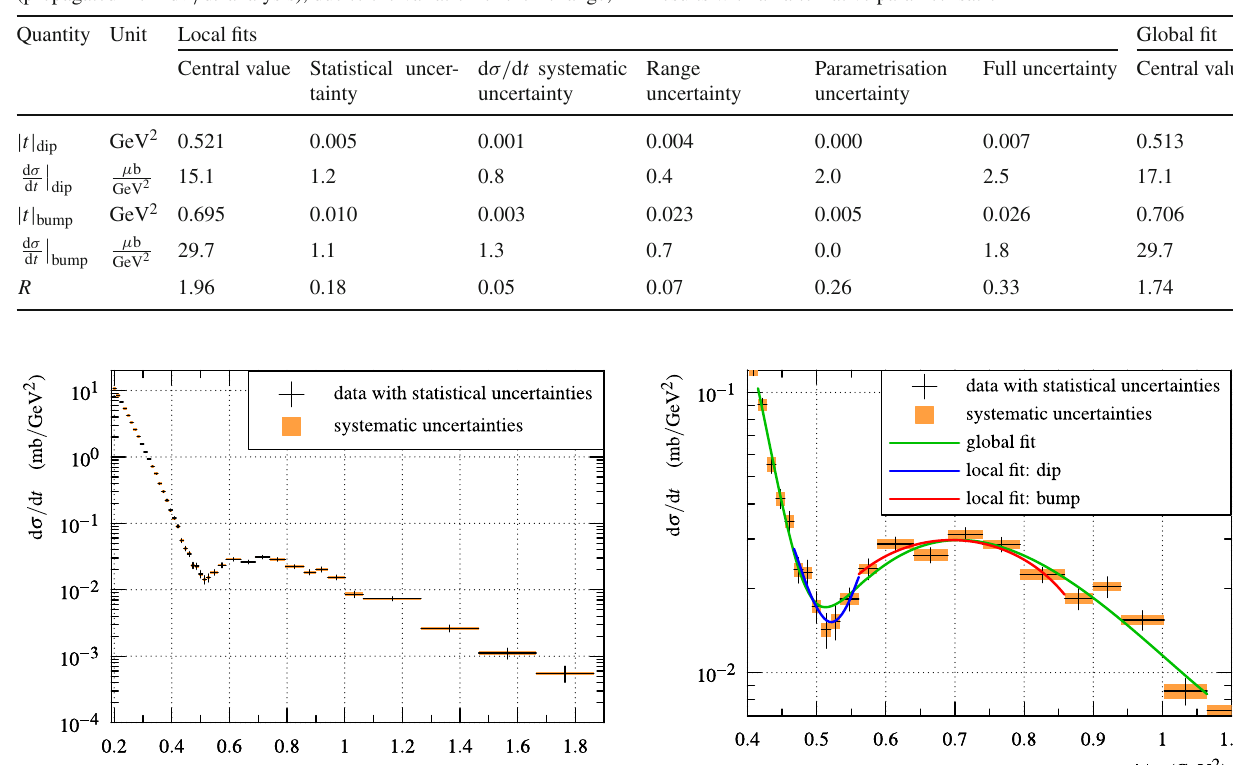
Table 2 Dip and bump parameters as extracted by the local fits (central part) and the global fit (right-most column) techniques. The uncertain- tiesquotedforthelocalfitsare(fromlefttoright):statistical,systematic (propagated from d σ/ d t analysis), due to the variation of the fit range,